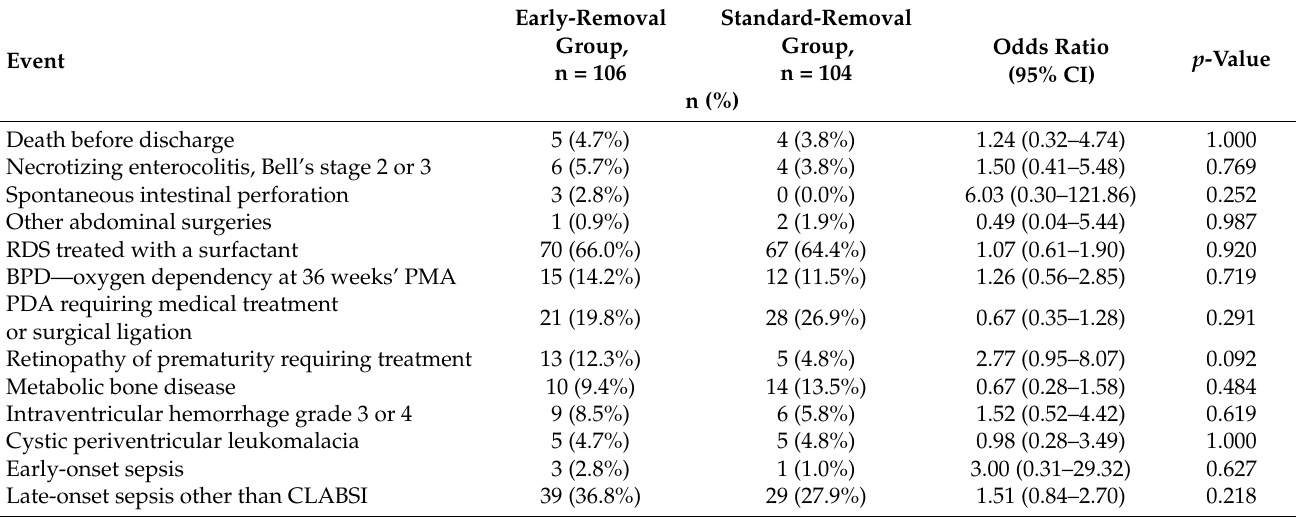
Table 3. Mortality and major preterm